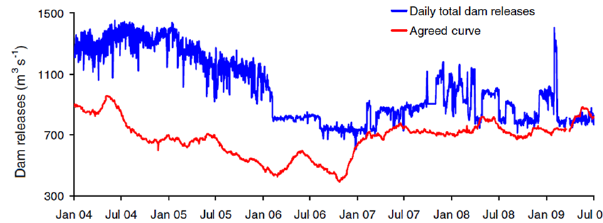
Figure 2. Observed daily total dam releases (blue line) and the agreed curve (red line) at the outlet of Lake Victoria in Jinja from November 2007 to July 2009 (Owor et al., 2011).